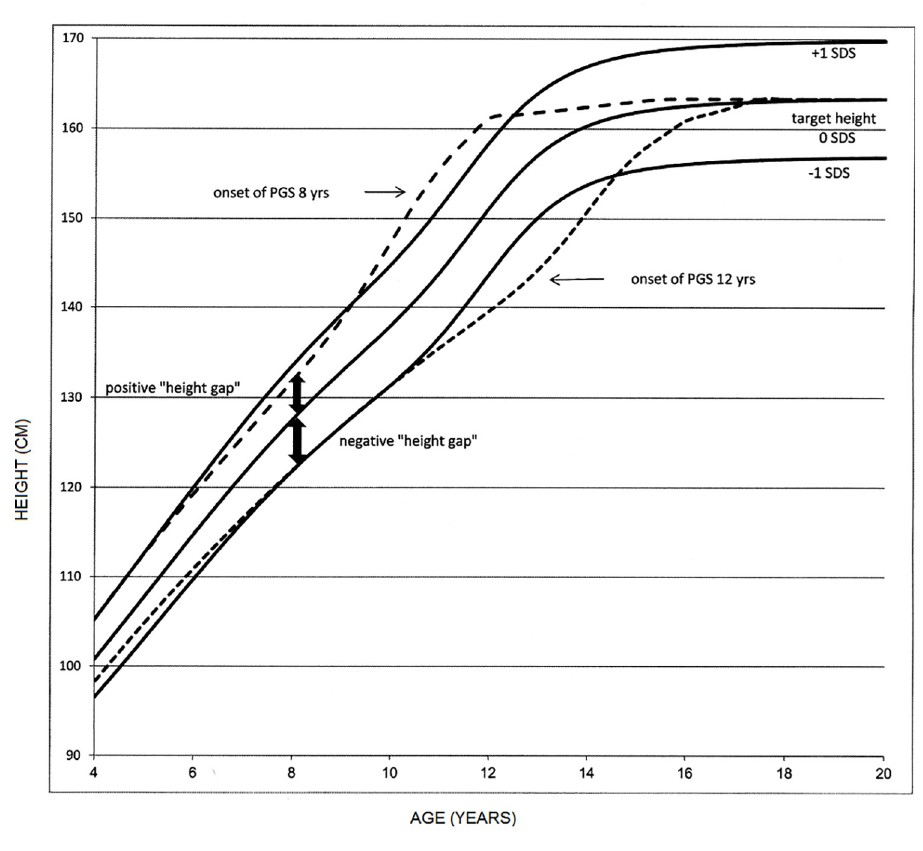
Fig 1. "Height gap" and the age of onset of the pubertal growth spurt. In this example, the target height is set to 0 SDS. The lines of 0, +1 and -1 SDS were generated using the Z scores of the heights of girls from the CDC 2000 tables [23]. The lines that describe the growth of girls whose onset of the PGS occurred at 8 years and 12 years were generated using the equations of the ICP model [21]. The "height gap" is the difference between the pre-pubertal child’s height and his/her target height both of which are expressed in SDS. As is shown in this example, the positive "height gap" is associated with an early PGS and the negative "height gap" is associated with a delayed